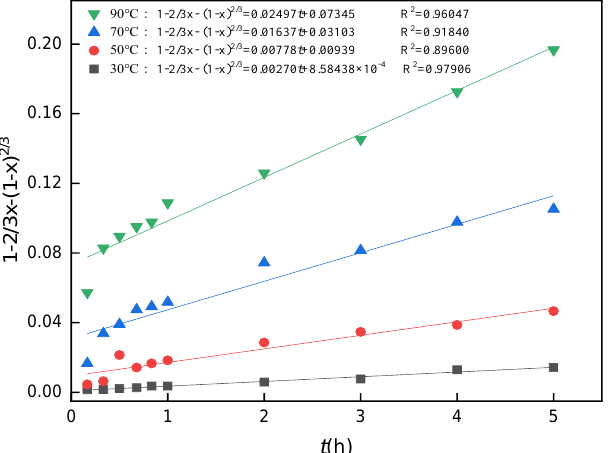
Figure 16. Relationships between (1 − x ) − 1/3 − 1 + 1/3ln(1 − x ) and time of aluminum ions.